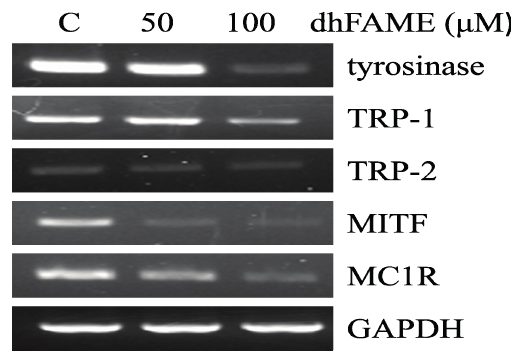
Figure 6. Effect of dhFAME on mRNA expression of melanogenesis-related genes in Melan-a cells. The cells were cultured for 24 h, and then the medium was replaced with fresh medium containing various concentrations (50 and 100 μ M) of methyl ester for 24